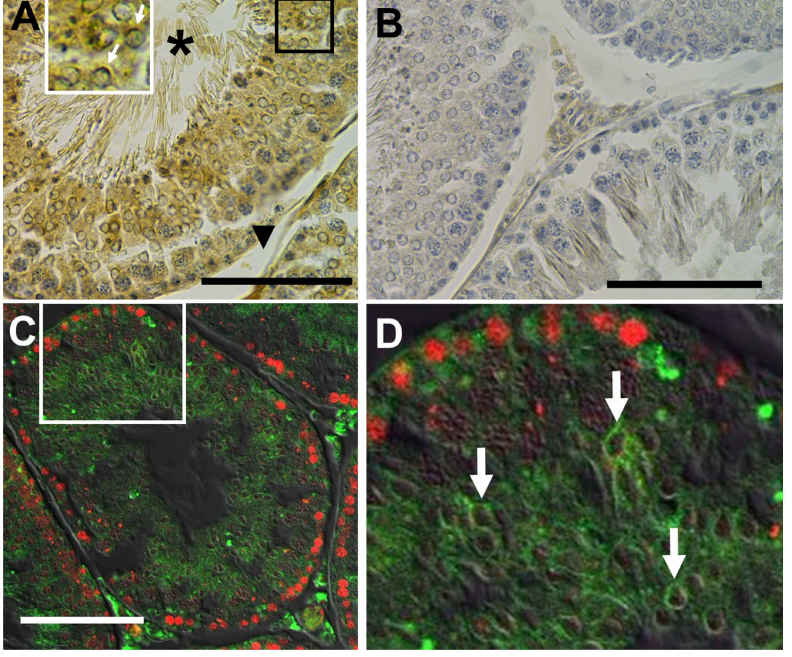
Fig 2. GPR120 immunohistochemistry and immunofluorescence. Representative immunohistochemistry and immunofluorescenceimages of 60 day old rat testes slices cut in a cryostat using an anti-rat GPR120 rabbit antibody (4 μ g/mL) (A, C and D). The secondaryantibody and stain developingsystem was a donkey anti-rabbitantibodycoupledto an HRP/DAB system (A and B). A control using rabbit pre-immune serum insteadof primary antibody is shown in (B). White arrows point toward spermatids. The asterisk ( * ) and the black arrow head indicateseminiferous tubule lumen and insterstitium, respectively. The bar shown in Figures A, B and C represents 100 μ m. C. Confocalimages obtainedusing as primary antibodiesan anti-rat GPR120 rabbit antibody (8 μ g/mL) and an anti-PCNA mouse antibody. An anti-rabbitIgG antibodyconjugatedto Alexa Fluor 488 and anti-mouse IgG antibody conjugated to DyLight 549 were used as secondary antibodies.D. Amplified image of the square shown in